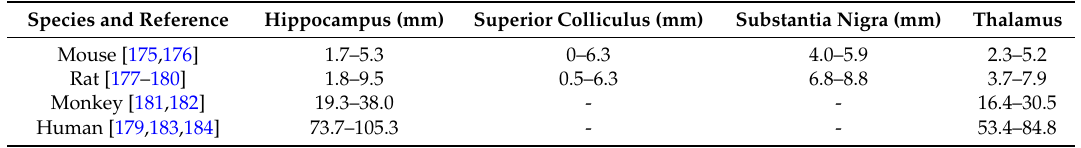
Table 5. Depths * of various brain targets across